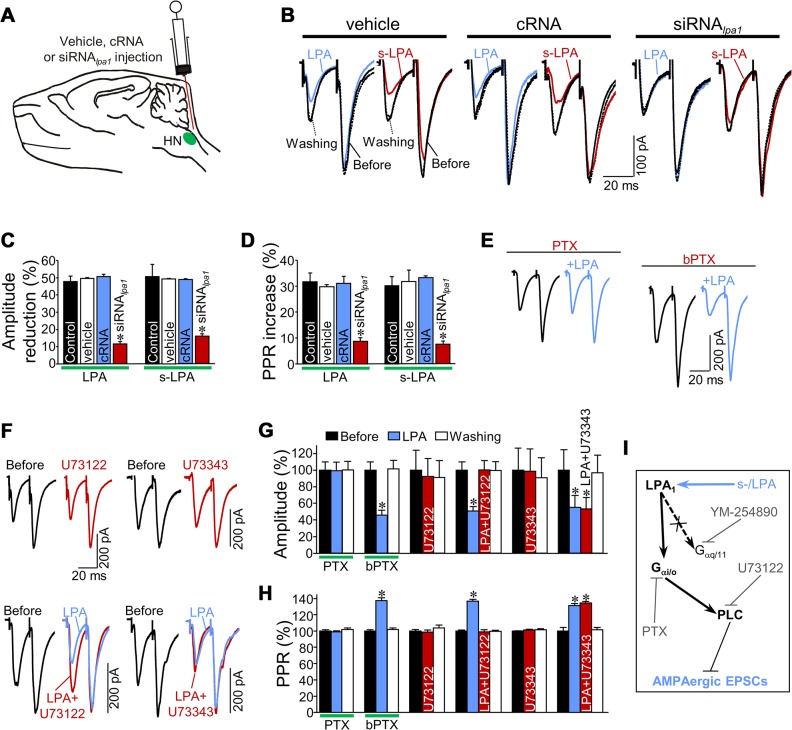
LPA modulates AMPAR-mediated neurotransmission via LPA1/Gαi/o-PLC.(A) Schematic diagram of microinjections performed in the fourth ventricle of neonatal rats at P4. A solution (2 μl) containing the vehicle (RNase-free phosphate-buffered saline [PBS]), control noninterfering RNA (cRNA, 2 μg) or a small interfering RNA directed against lpa
1 (siRNAlpa1, 2 μg) was administered by means of a Hamilton syringe. (B) Representative eEPSCsAMPA recorded in HMNs obtained from animals receiving the specified treatments recorded at the indicated conditions. (C, D) Mean eEPSCsAMPA amplitude reduction (C, in percent) and PPR ratio increase (D, in percent) in response to addition to the bath of LPA (2.5 μM) or s-LPA (40 μM) measured at 25 ms interpulse intervals for HMNs recorded under the indicated treatments (control, LPA: n = 13 HMNs, s-LPA: n = 6 HMNs; vehicle, LPA: n = 6 HMNs, s-LPA: n = 4 HMNs; cRNA, LPA: n = 6 HMNs, s-LPA: n = 4 HMNs; siRNA, LPA: n = 9 HMNs, s-LPA: n = 5 HMNs). *p < 0.05, one-way ANOVA relative to control, vehicle and cRNA conditions. (E) Effect of LPA on eEPSCsAMPA from two HMNs in response to paired-pulse stimulation under the presence of the Gαi/o inhibitor pertussis toxin (PTX) (100 ng/ml; left) or the noncatalytic B oligomer of PTX (bPTX) (100 ng/ml; right). Slices were preincubated for 2 h with PTX or bPTX before recordings began and were maintained throughout the experimental procedure. (F) Representative eEPSCsAMPA from 4 HMNs in response to paired-pulse stimulation of VLRF showing the effects of the PLC inhibitor U73122 (1 μM) or its inactive analog U73343 (5 μM) per se (top) or coadded after previous incubation for 10 min with LPA (bottom). (G, H) Mean eEPSCsAMPA amplitude and PPR ratio (25 ms interpulse intervals) under the indicated treatments (PTX and bPTX, n = 6 HMNs; U73122, n = 5 HMNs; LPA+U73122, n = 5 HMNs; U73343, n = 4 HMNs; LPA+U73343, n = 5 HMNs). *p < 0.05, one-way RM-ANOVA relative to control (before) condition. (I) Diagram of the proposed pathway mediating LPA-induced STD at AMPAergic signaling, indicating drug targets. Plots data can be found in S1 Data.